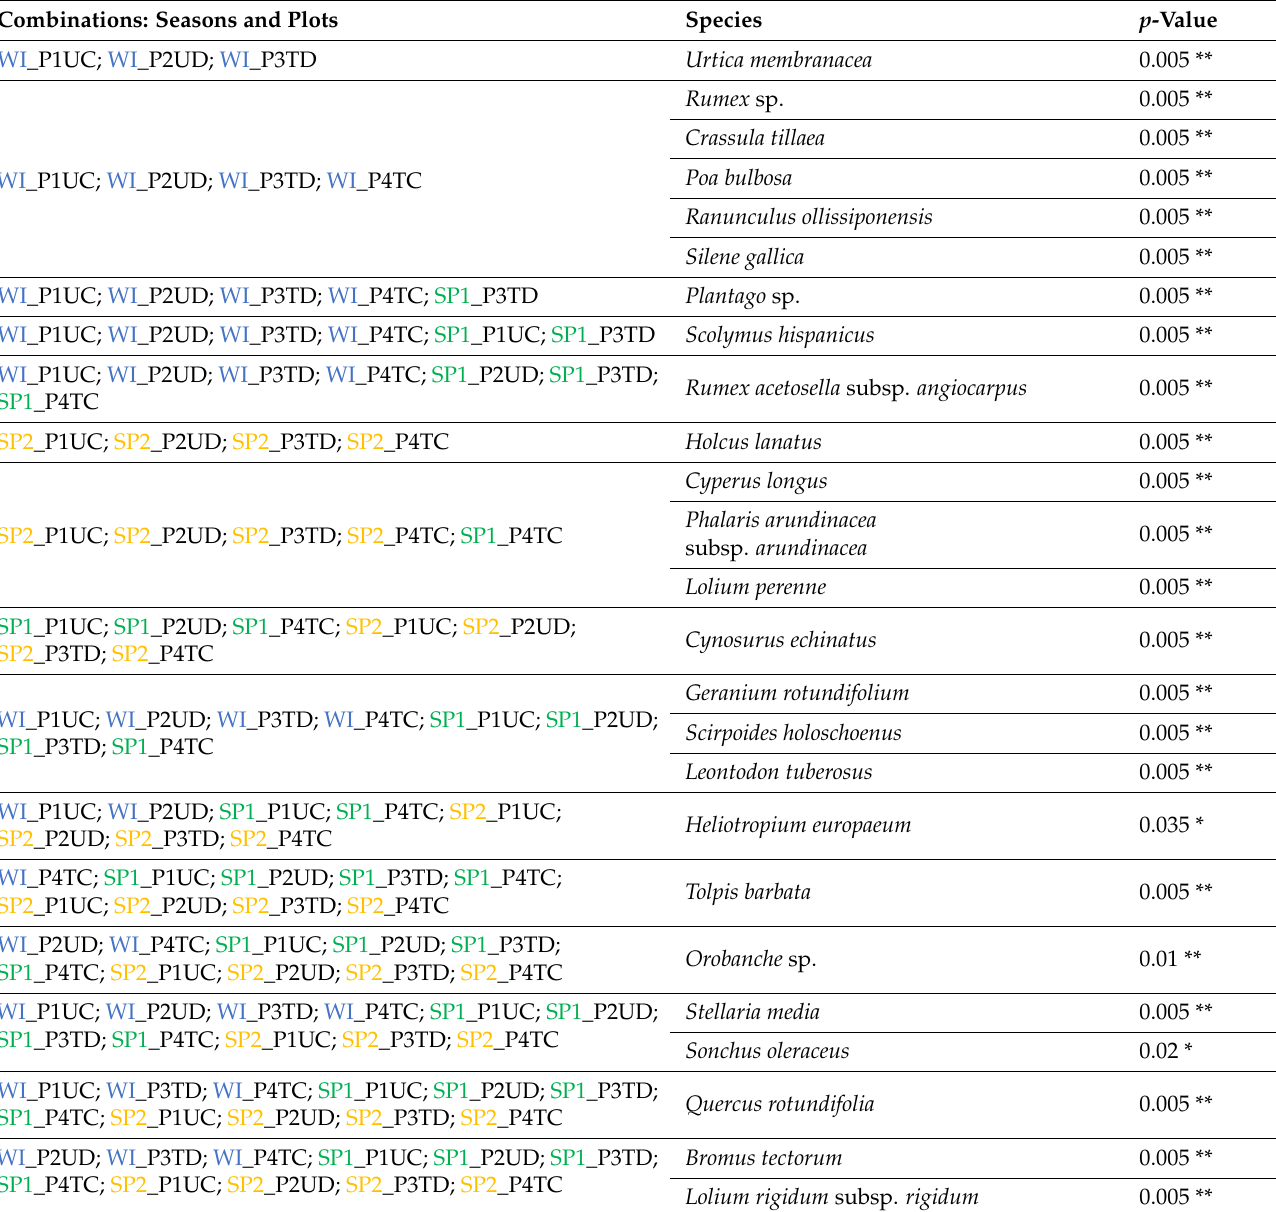
Table 1. Analysis of indicator species (ISA) for bioindicator species for the combinations between season (WI, SP1 and SP2) and treatment (P1UC, P2UD, P3TD and